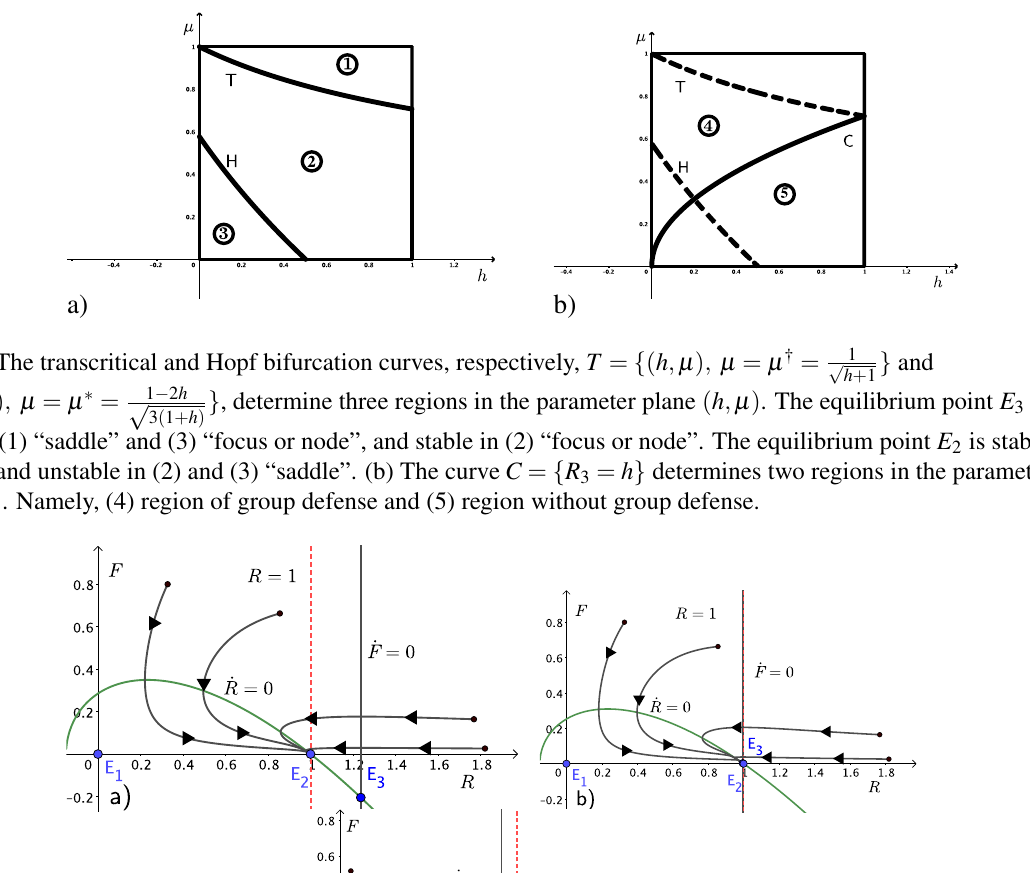
Fig. 3 The transcritical bifurcation between the equilibrium points E 2 and E 3 as function of the bifurcation parameter µ . a) For µ = 1 . 05, λ = 0 . 7 and h = 0 . 15, E 2 is a stable node and E 3 is a saddle. b) E 3 = E 2 is a nonhyperbolic equilibrium for µ = µ † ≈ 0 . 932, λ = 0 . 7 and h = 0 . 15. c) For µ = 0 . 88, λ = 0 . 7 and h = 0 . 15, E 2 is a saddle and E 3 is a stable